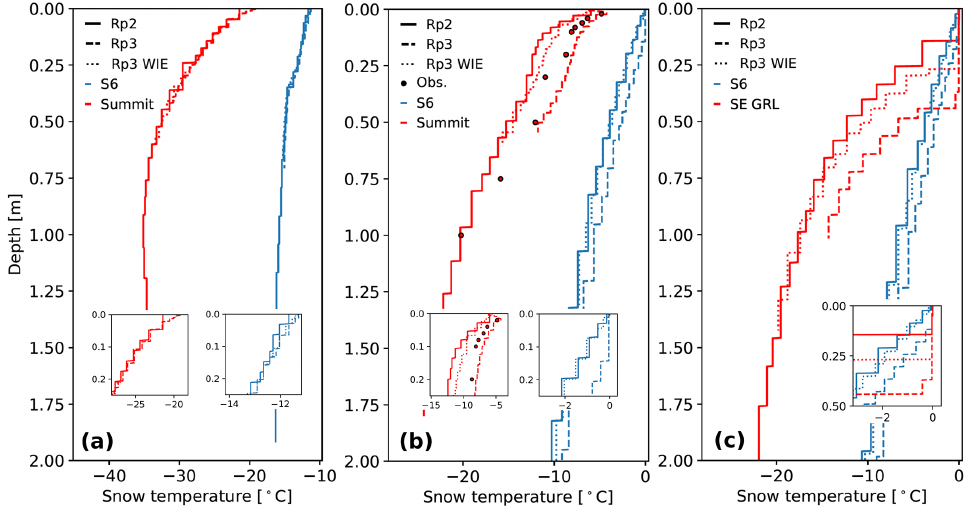
Figure 4. Subsurface temperature profiles for the 20 upper snow layers of Rp2, Rp3, and Rp3 without internal energy absorption (WIE) and observations (Obs.) for S6 and Summit for (a) a winter day (29 January 2007) and (b) a summer day (10 July 2007) at 15:00UTC. No observations are available for Summit on this winter day. (c) Subsurface temperature profiles for a location in the accumulation zone of southeast Greenland (SE GRL, star in Fig. 5c) and S6 during a melt event (22 June 2012, 15:00UTC). The insets show the results of the upper layers in more